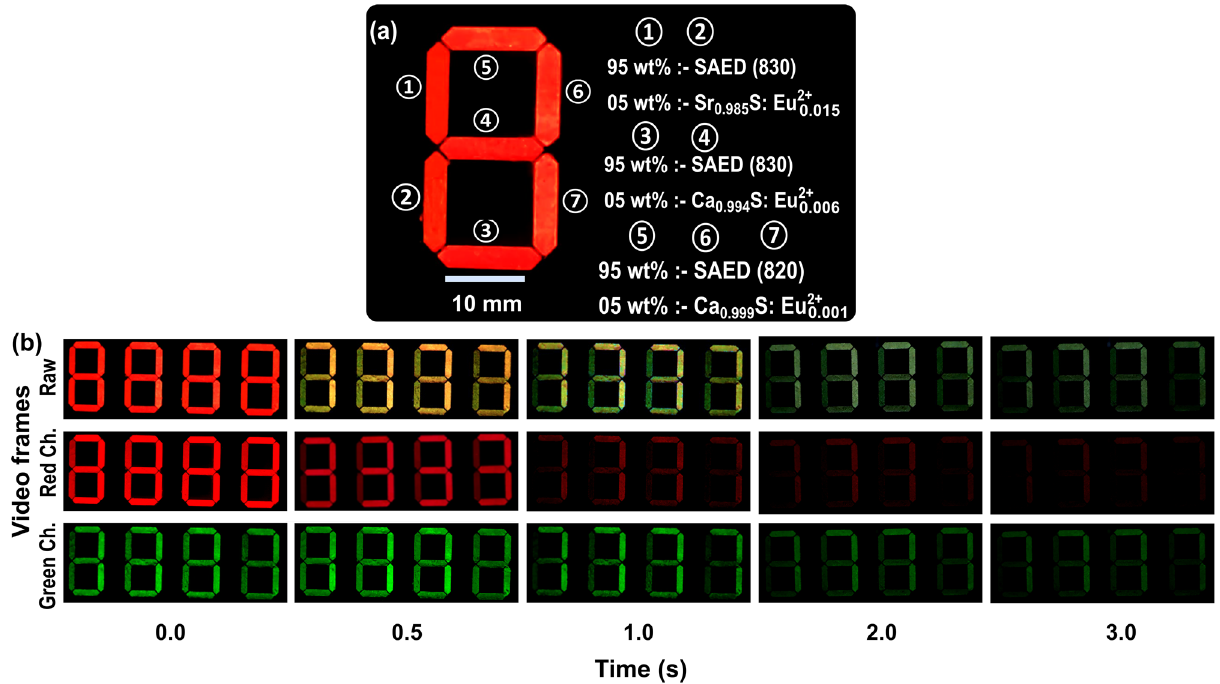
Figure 4. Demonstration of color and pattern changing persistent luminescence anti-counterfeiting labels following smartphone excitation. (a) Schematic representation detailing the phosphors placed in each of the 7-segment display. (b) Smartphone acquired video frames of interest for four digits of the 7-segment display described in (a) after 5 s excitation with smartphone-flashlight. The raw video frames are then split in to the red and green channels. The raw video transitions from ‘8 8 8 8’ in red, to a yellowish (red and green) ‘3 3 3 3’ and finally to a green ‘7 7 7 7’ at 0.5 s and beyond 1 s respectively. Exploring the red channels reveals that the initial ‘8 8 8 8’ in red, transitions to a ‘3 3 3 3’ and finally to a red ‘7 7 7 7’ at 0.5 s and beyond 1 s respectively. The first and second transition is due to exhaustion of majority of the red emission emanating from Sr 0.985 S:Eu Ca 0.994 S:Eu 2 + 0.006 in segments ① — ② and ③ — ④ respectively. This is different from the green channel transition where the initial red-channel-concealed ‘8 8 8 8’ transitions directly to a green ‘7 7 7 7’ at 0.5 s as the segments ① — ④ contained on SAED (830) and ⑤ — ⑦ has SAED